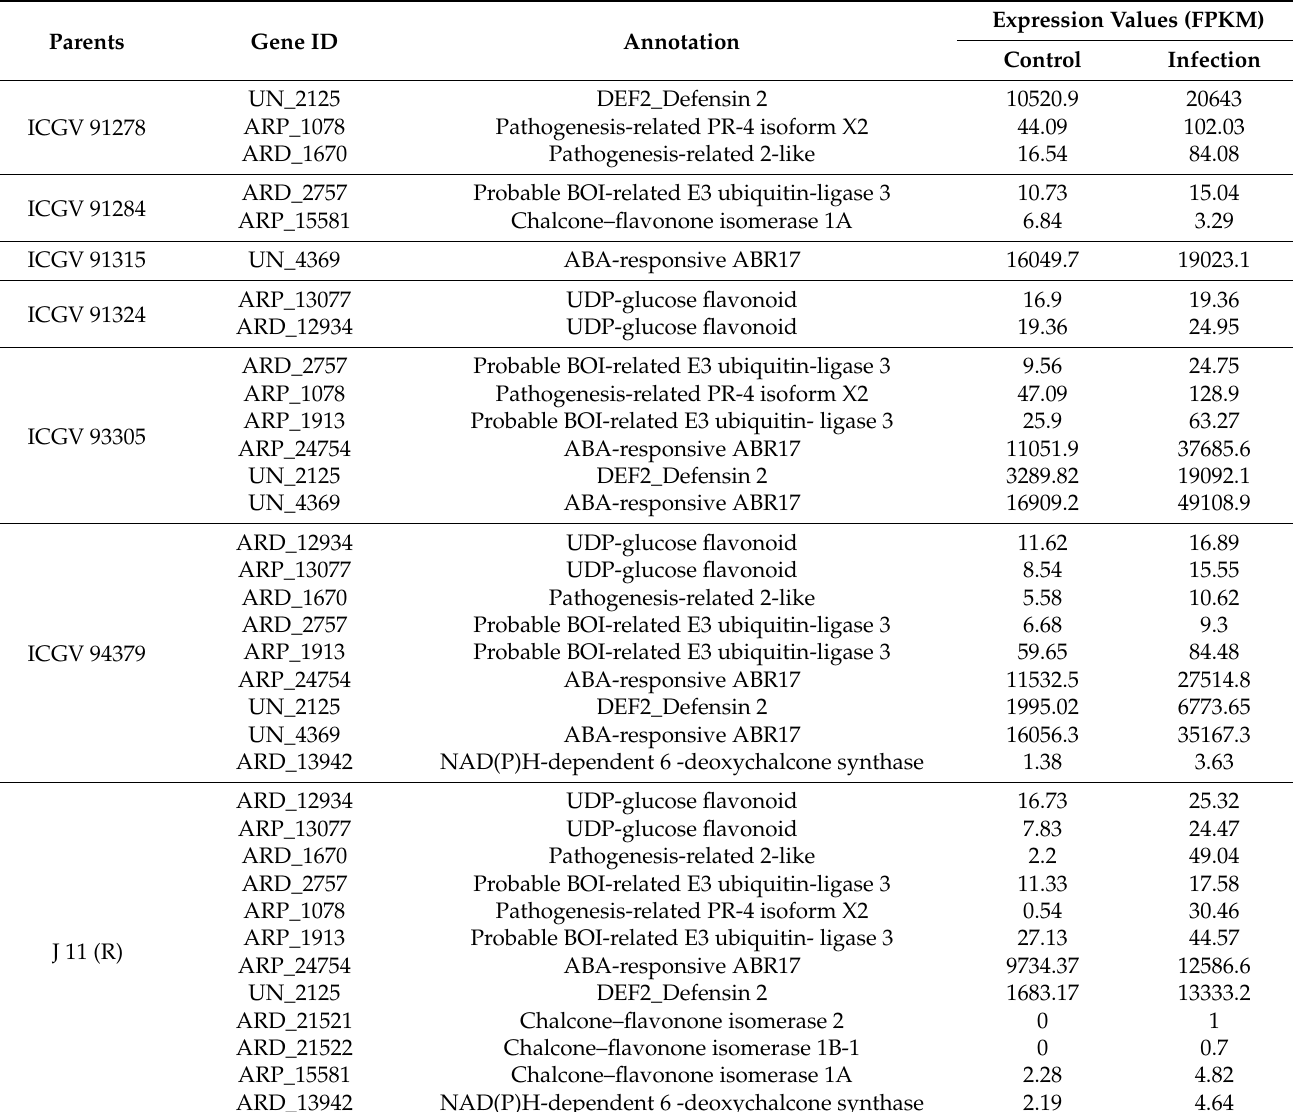
Table 2. Highly differentially expressed putative candidate genes for PAC in